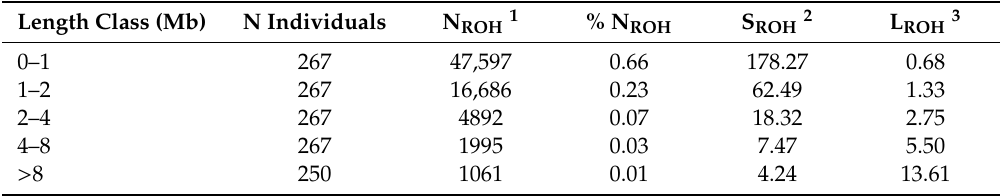
Table 4. Runs of homozygosity (ROH) of different length classes in individual genotypes. Length Class (Mb)